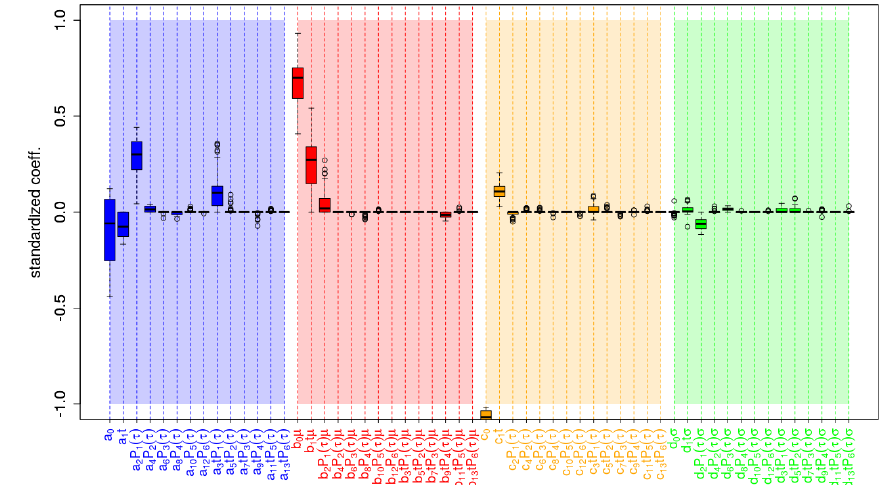
Figure 12. Identified coefficients for recalibrating the mean 2m temperature over the North Atlantic of the prototype. Here, the coef- ficients are grouped by correcting uncond. bias (blue bars), cond. bias (red bars), uncond. dispersion (orange bars) and cond. disper- sion (green bars). The coefficients are standardized, i.e., with higher values implying a higher relevance. Values refer to coefficients a 0 ,b 0 ,c 0 ,d 0 ,...,a 6 ,b 6 ,c 6 ,d 6 and not to the product between these coefficients and the corresponding predictors (e.g., a 2 P 1 (τ) refers to a 2 ).